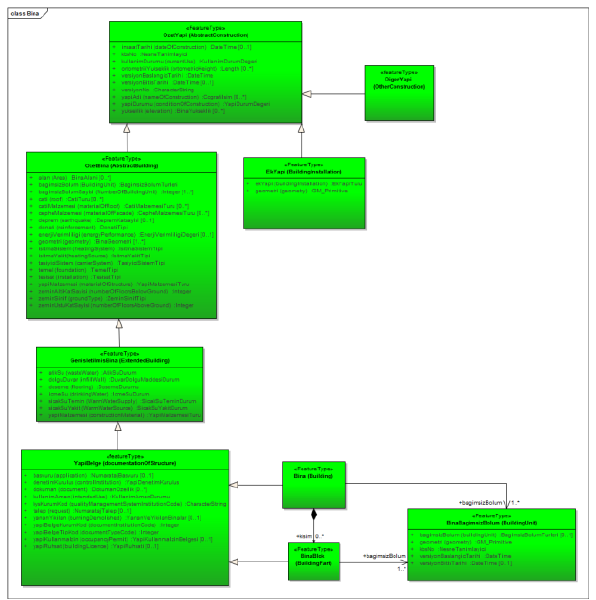
Figure 3. TRKBIS-Building data